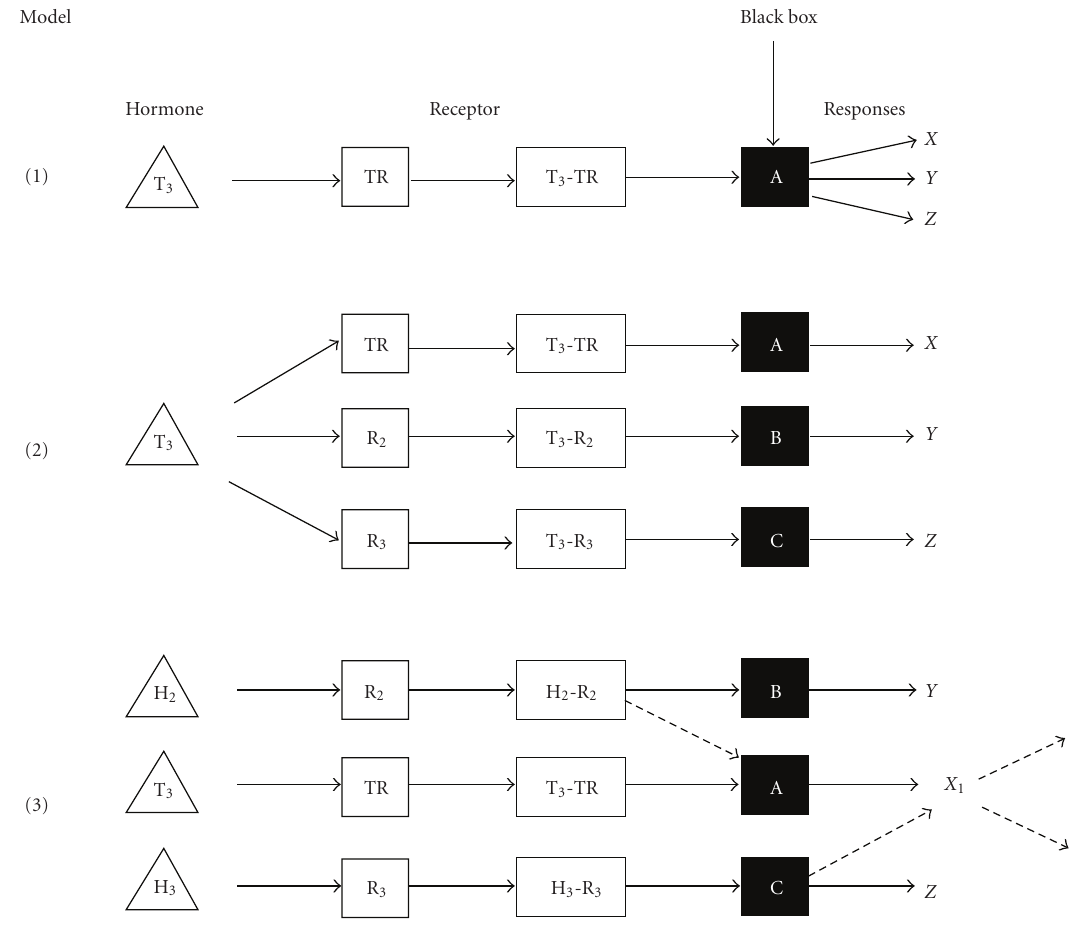
Figure 3: Three hypothetical models for thyroid hormone action depicting permutations of multiple hormonal interplay at the postreceptor level, represented by “Black Boxes” A, B, and C. According to model 1, the simplest situation is that T 3 interacting with a single thyroid hormone receptor (TR) modifies the activity of a key postreceptor complex which gives rise to a chain of multiple responses X , Y , Z . The multiplicity of responses to a hormone may also arise from di ff erent chemical or structural isoforms of a single receptor, represented in model 2 as TR, R 2 and R 3 together giving rise to multiple actions through functionally di ff erent Black Boxes. Alternatively, the same single receptor is present in di ff erent cellular locations and behaves e ff ectively as di ff erent receptors (TR, R 2 , R 3 ) in the same or di ff erent cells. In model 3, the multiplicity is a function of another hormone or signal (H 2 , H 3 ), acting via di ff erent receptors (R 2 , R 3 ) to modify the nature, multiplicity, or extent of the action(s) of T 3 , either before or after the action at the level of Black Boxes. The multiplicity, can also result from further downstream interactions of the postreceptor responses (e.g., X 1 , X 2 , and X 3